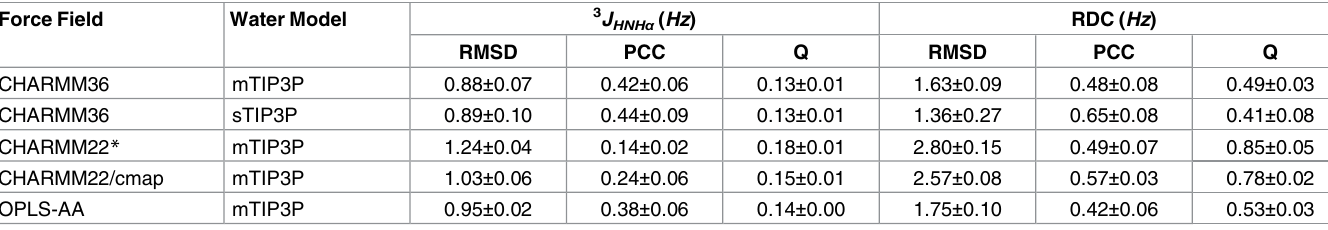
Table 7. Comparison of experimental and computational J -coupling and RDC constants †